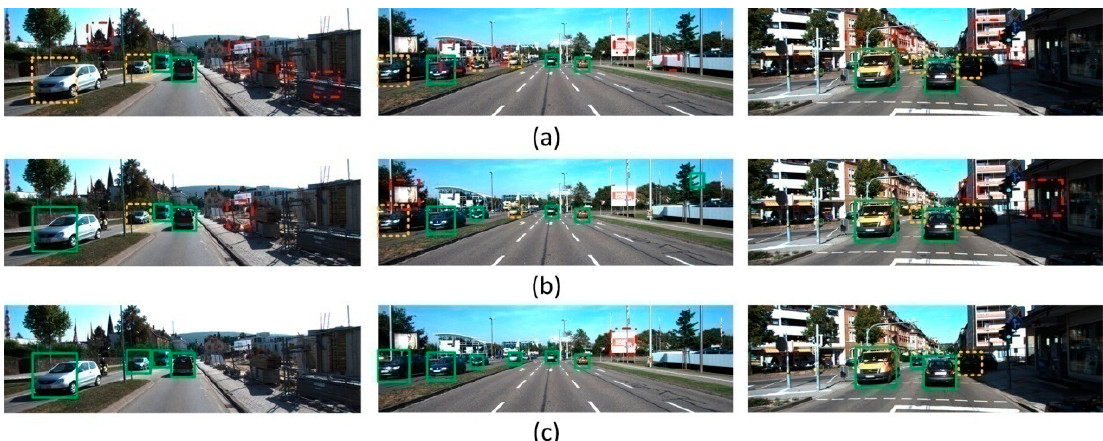
Figure 10. Example test results for different methods using the KITTI test data set. (a) Test results of ITL-Adaboost; (b) Test results of Confidence-Encoded SVM; (c) Test results of our method